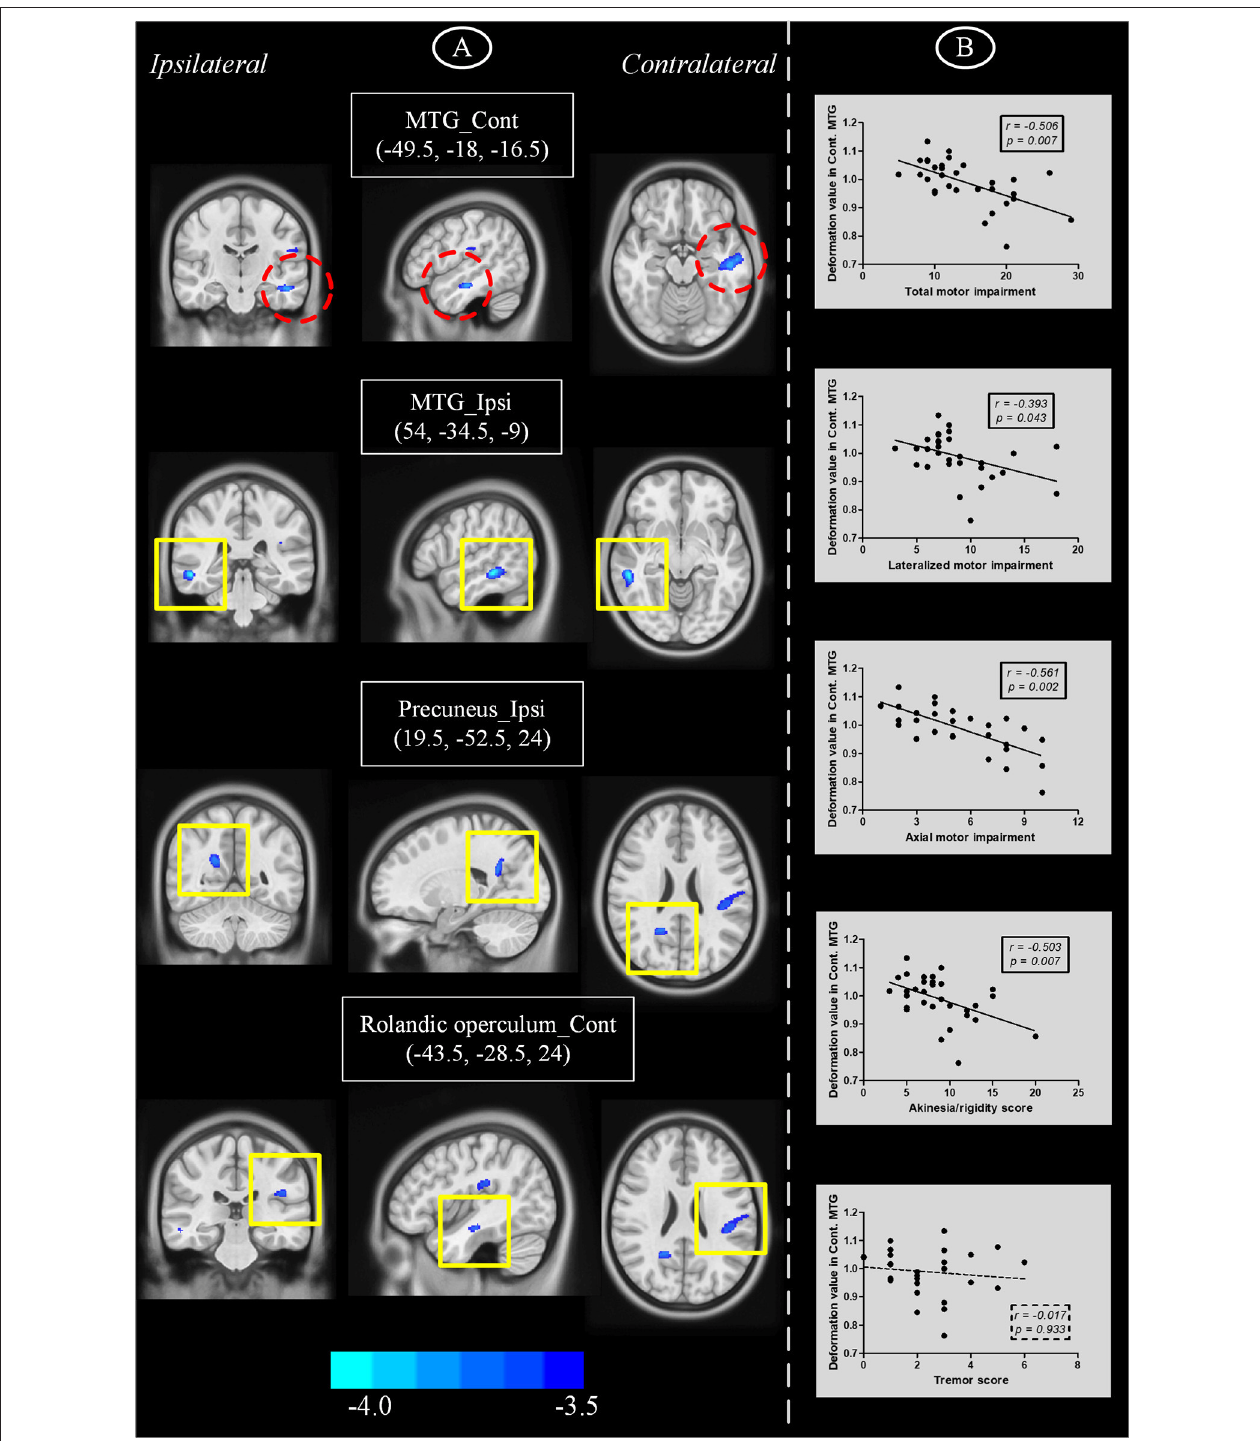
FIGURE 2 | (A) Brain atrophy in PD patients with hemiparkinsonism compared with normal controls as measured by deformation-based morphometry. (B) Plots showing that decrease of deformation value in contralateral MTG was correlated with motor impairment. Cont, contralateral; ipsi, ipsilateral; MTG, middle temporal